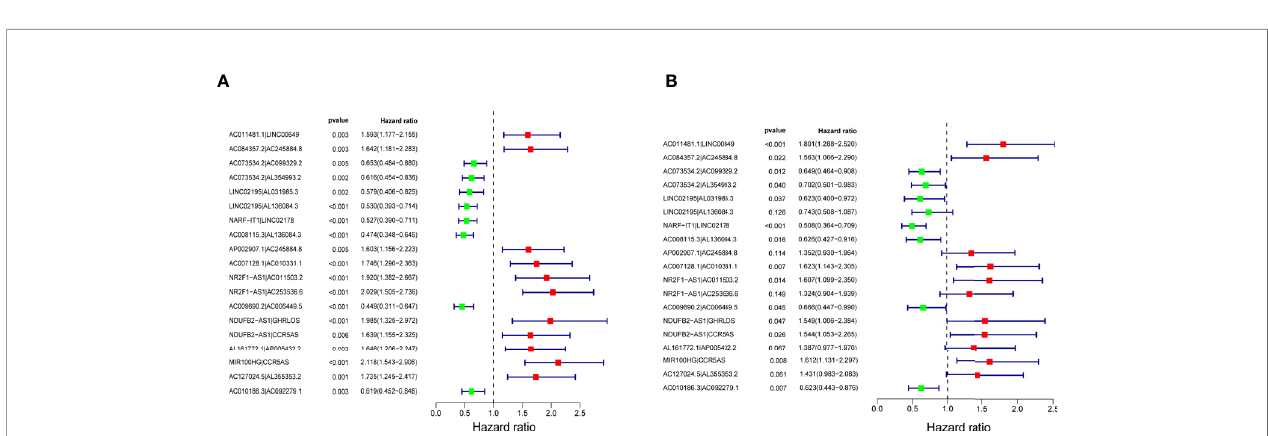
FIGURE 1 | Differentially expressed immune-related lncRNAs (DEirlncRNAs) were identi fi ed using TCGA datasets and visualized in heatmap (A) and volcano plot